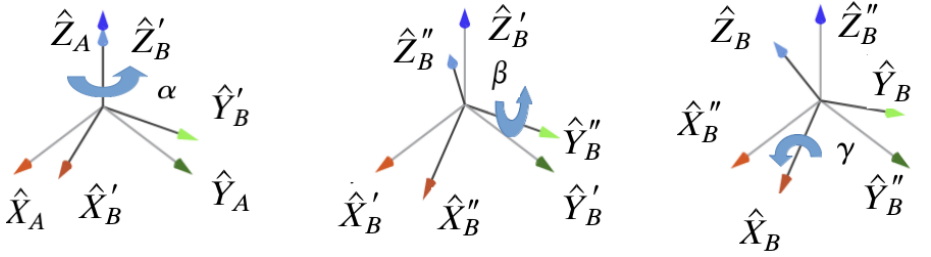
Figure 2. Representation of a sequence of small rotations around principal